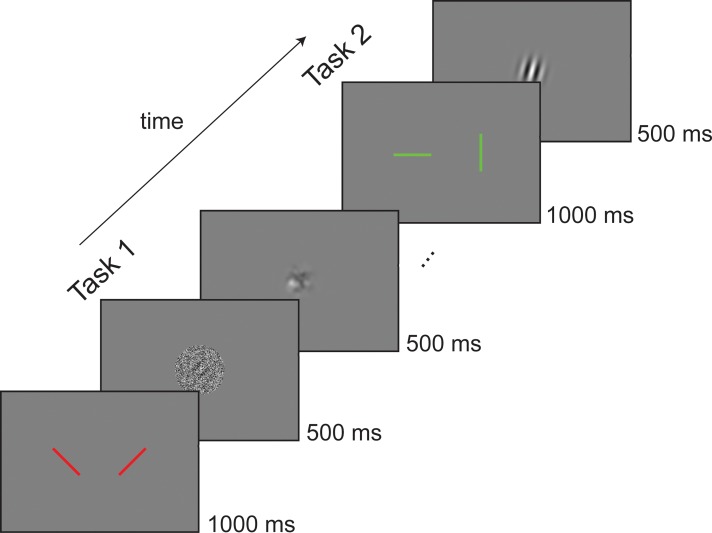
Example of one trial in the dual task of Experiment 4.In the first task of each trial, participants were cued by two oblique red bars to report the left versus right orientation of an upcoming Gabor presented with different SNRs (0%, 25%, 75%, 25% is shown as a representative condition) and followed by a noise mask. In the second part, green cardinal lines cued participants to report the vertical/horizontal deviation of the orientation of a second Gabor. SNR, signal-to-noise ratio.